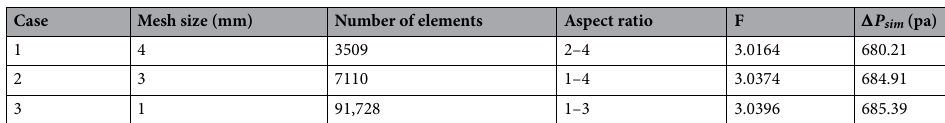
Table 3. Mesh independence analysis in three different mesh sizes for turbine meter oil as the operating fluid with a velocity inlet of 0.069 41 .